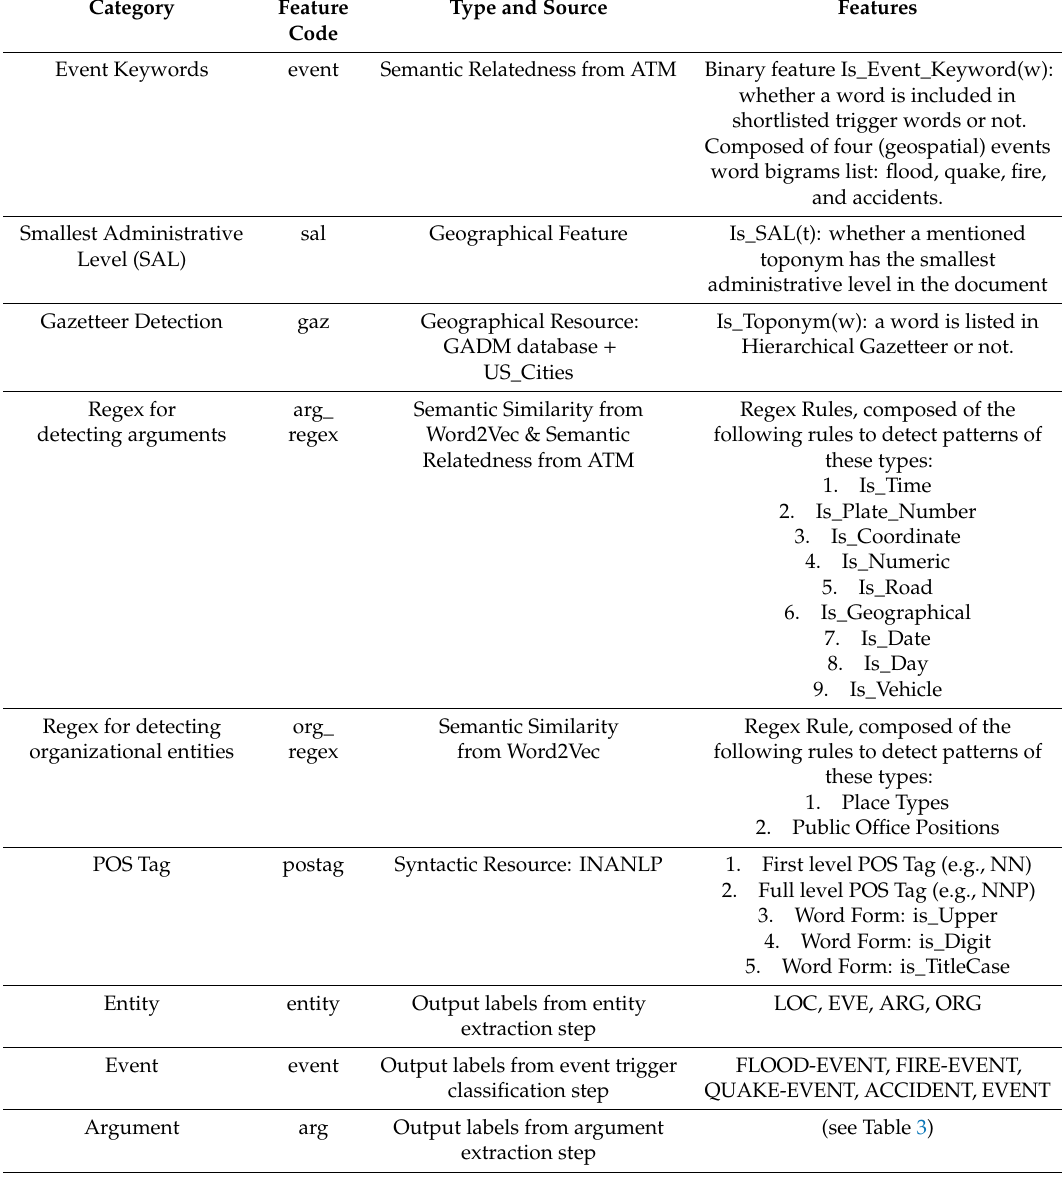
Table 4. Features for entity, event, argument, and pseudo-location